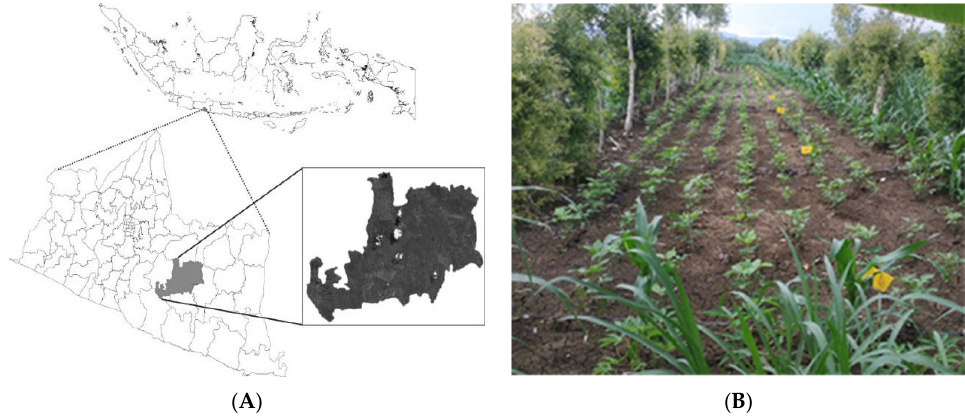
Figure 1. ( A ) Geographical locations of the study site (latitude 7°52 ′ 59.5992 ″ S to 7°59 ′ 41.1288 ″ S and longitude 110°26 ′ 21.462 ″ E to 110° 35 ′ 7.4868 ″ E) and ( B ) soybean among kayu putih stands.